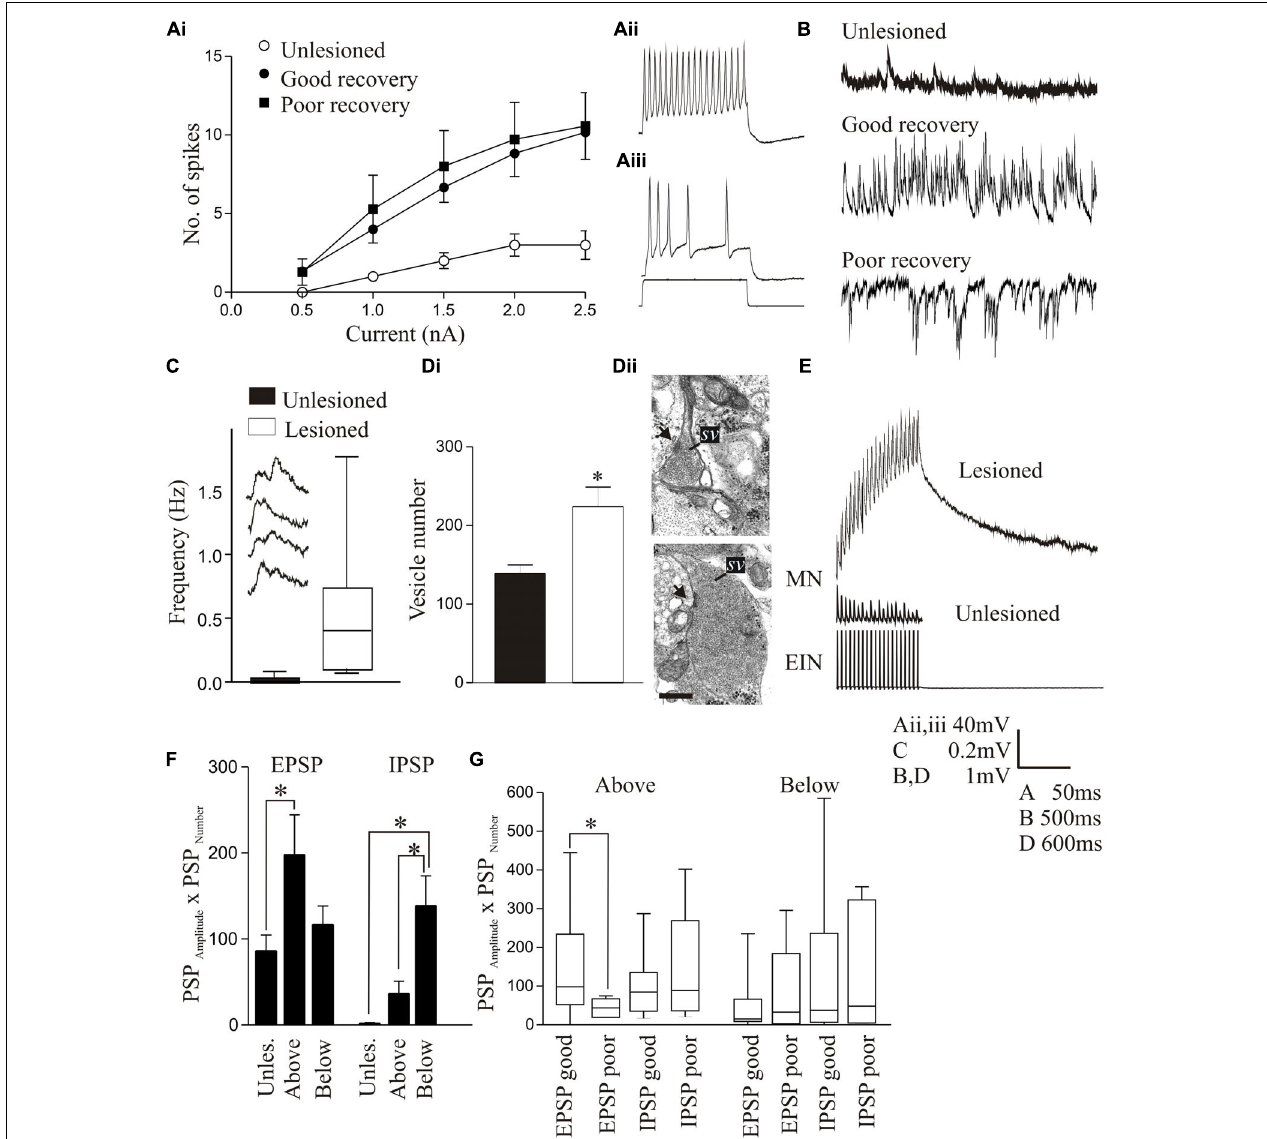
FIGURE 4 | Lesion-induced changes in cellular properties. (Ai) Graph showing changes in excitability in unlesioned larvae, and in lesioned larvae showing good and poor recovery. Traces show excitability changes in a lesioned (Aii) and unlesioned animal (Aiii) . (B) Spontaneous synaptic inputs in an unlesioned spinal cord, and below the lesion site in animals that showed good or poor recovery. (C) Graph and traces showing “double” spontaneous miniature EPSPs. (Di) Graph showing the number of vesicles in synaptic terminals in an unlesioned and a lesioned spinal cord. (Dii) Electron micrographs showing examples of putative glutamatergic synapses in an unlesioned (top) and a lesioned spinal cord (below). (E) Example of an excitatory interneuron to motor neuron connection in an unlesioned animal and the slow depolarization that occurs at the same type of connection in a lesioned animal. (F) Changes in spontaneous synaptic inputs above and below the lesion site in juvenile adult animals. (G) Changes in excitatory and inhibitory synaptic inputs above and below the lesion site in juvenile animals that recovered well or poorly. Data is presented as a boxplot to indicate the variability. Data from Cooke and Parker (2009) and Becker and Parker (2015). No permission is required to reproduce this material. ∗ Indicates statistical significance at p <